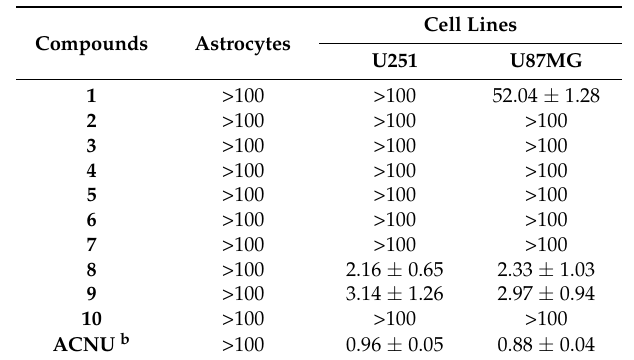
Table 2. Cytotoxicities of saponins 1 – 10 against two human cancer cell lines and primary cultured astrocytes in vitro (IC 50 , µ M) a